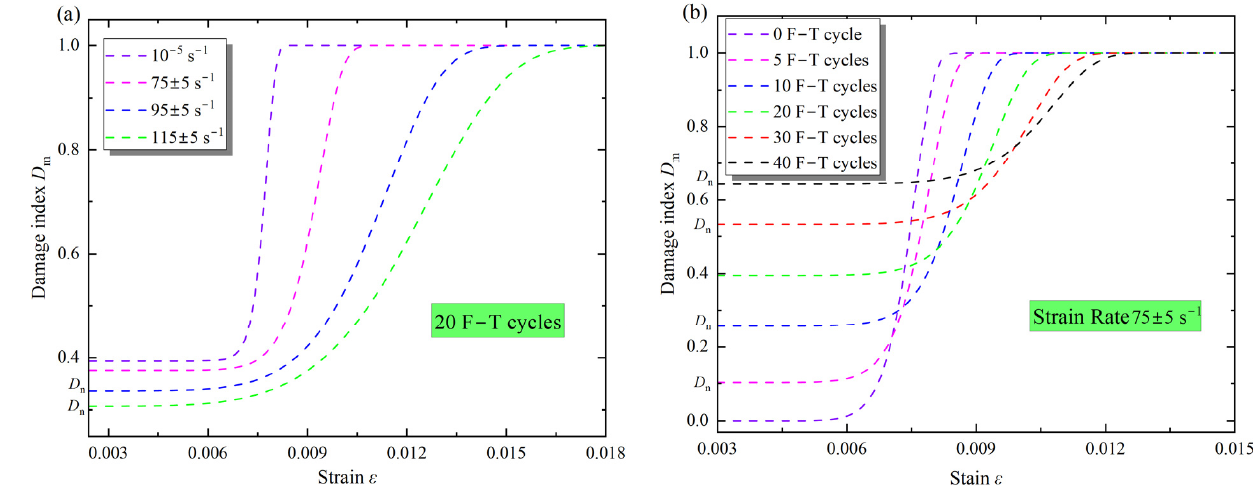
Figure 20. Damage D m evolution with strain rate ( a ) and F–T cycles ( b ) under impact loading. As shown in Figure 20a, the damage index D m in the initial phase corresponds to the F–T damage D n at different strain rates. After 20 F–T cycles, the D n decreases with increasing strain rate, and the D n at static loading is 0.395, which is about 1.5 times higher than that at 115 s − 1 . As the strain increases, the D m of the sample continues to increase, but it is always between 0 and 1. This is due to the gradual development of the pores and microcracks in the rock caused by the F–T action under the loading, which eventually aggravates the damage to the sample [20]. However, compared to static loading, there are significant differences in the D m development curves under dynamic loading: as the strain increases, D m develops earlier in the samples with larger strain rates, e.g., at the strain rate of 115 s − 1 , damage begins at a strain of about 0.004 compared to about 0.007 under static loading. Also, the growth rate of D m is greater under static loading, which means that the deformation during damage is less under static loading. As mentioned earlier, the peak strain of the sample increases with strain rate, leading to a decrease in the growth rate of D m with strain in Figure 17a. At the same time, the damage mode of the samples changes from brittle to ductile under the impact loading, which is reflected in a decrease in the decrease rate of post-peak stress [20]. Therefore, the D m of the sample under F–T action develops earlier under the impact loading, but the growth rate gradually decreases with the strain rate.